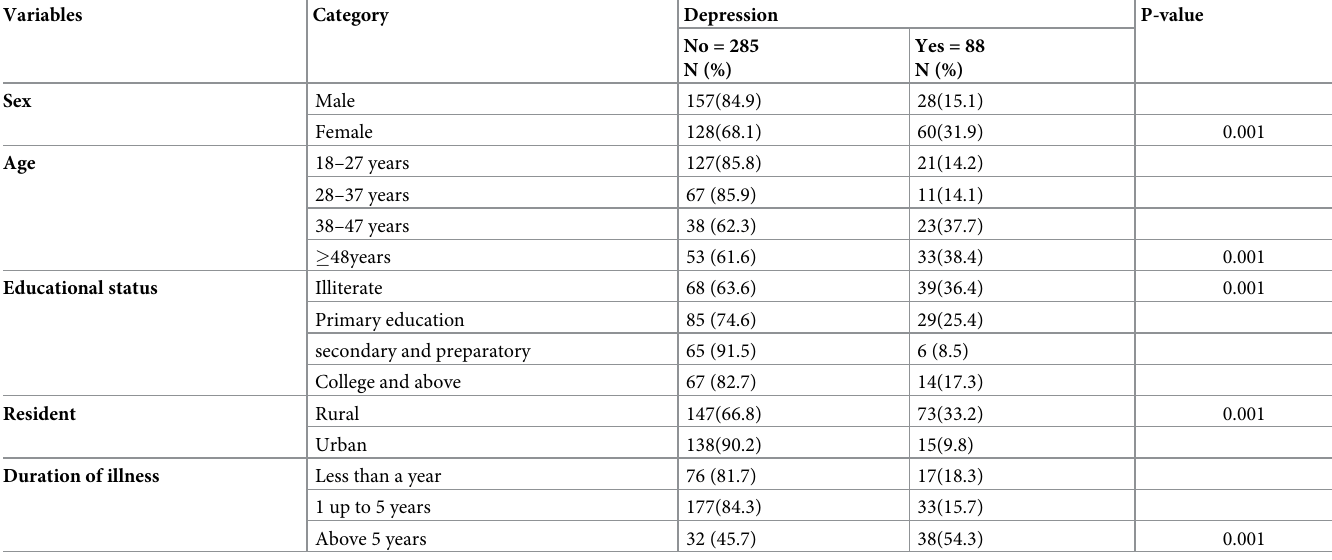
Table 1. Description of socio-demographic characteristics of the respondents depression satus with chronic skin disease at Boru Meda Hospital, Northeast Ethio- pia, 2021 (N = 373).